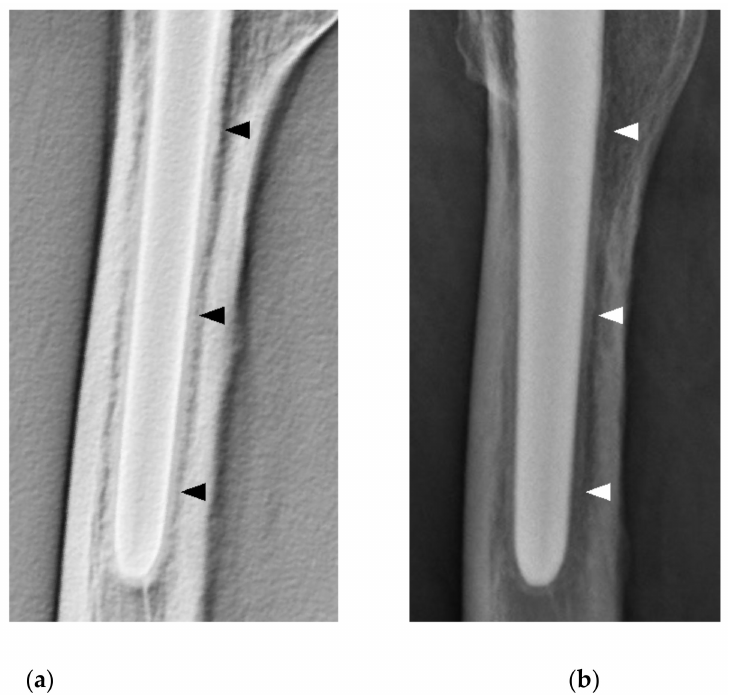
Figure 2. An 83-year-old female patient 3 y after THA. ( a ) DTS (lateral view); there was bone formation surrounding the stem (black arrowheads). ( b ) Plain radiographs (lateral view) of the same patient as in ( a ); there was cancellous condensation similar to a reactive line (white arrowheads). THA, total hip arthroplasty; DTS, digital tomosynthesis.